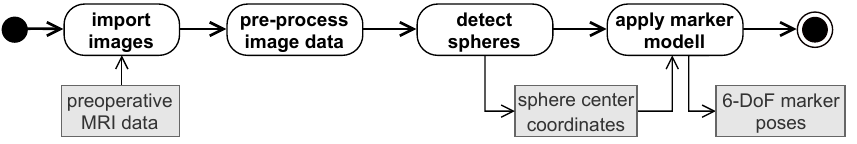
Figure 2. The general image processing